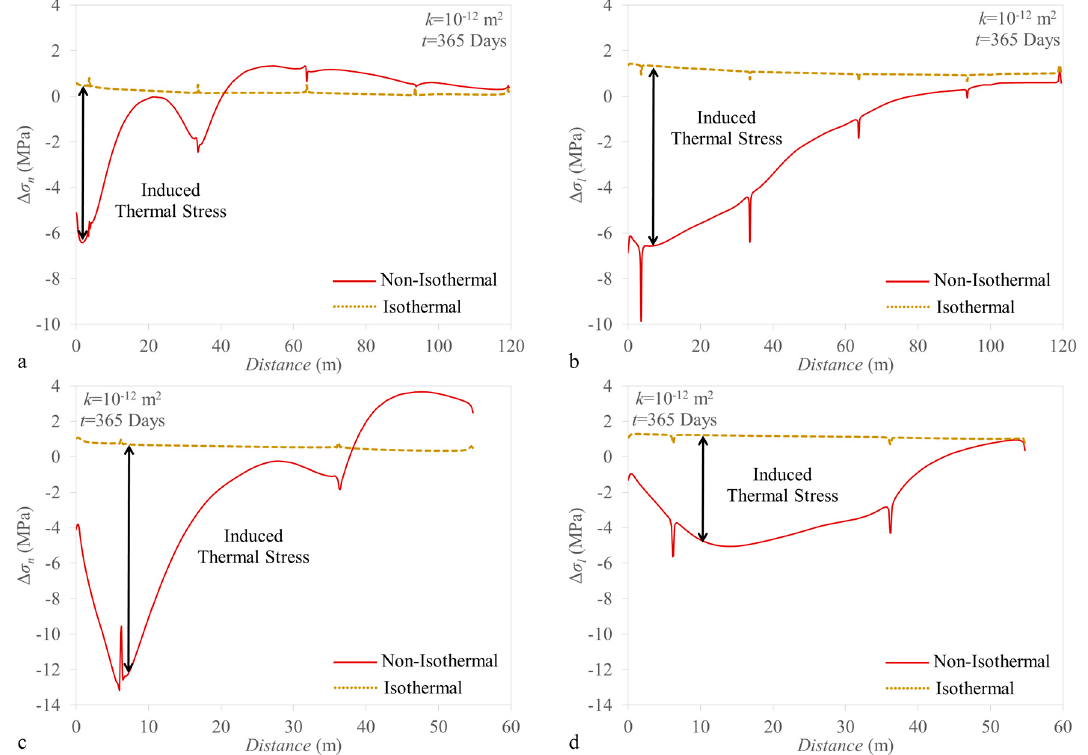
Figure 10. ( a ) Normal stress change along fracture A, ( b ) longitudinal stress change along fracture A, ( c ) normal stress change along fracture B and ( d ) longitudinal stress change along fracture B after 1 year of cold fluid injection for a fracture with intrinsic permeability of 10 − 12 m 2 .